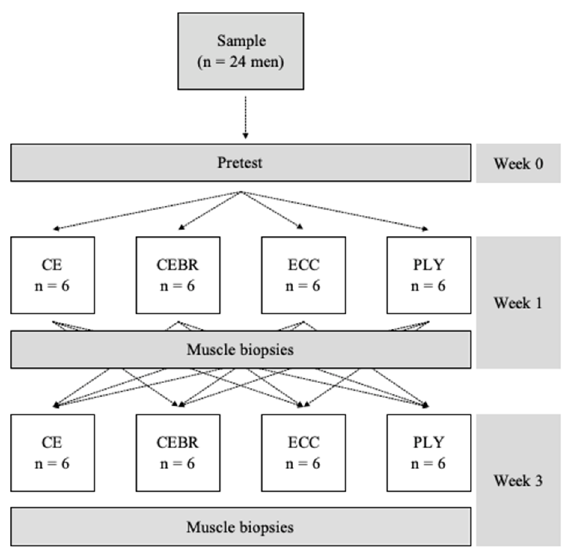
Figure 2. Study design. Vastus lateralis biopsies were taken after completion of the two exercise sessions, which were interspersed by a washout period of two weeks. CE is unilateral concentric-eccentric resistance exercise, CEBR concentric-eccentric resistance exercise followed by self-myofascial release using a blackroll ® , ECC eccentric-only resistance exercise and PLY plyometric exercise. A standard knee extension device was used for CE, CEBR and ECC. The PLY jumps were performed in a seated position using a commercially available training device.